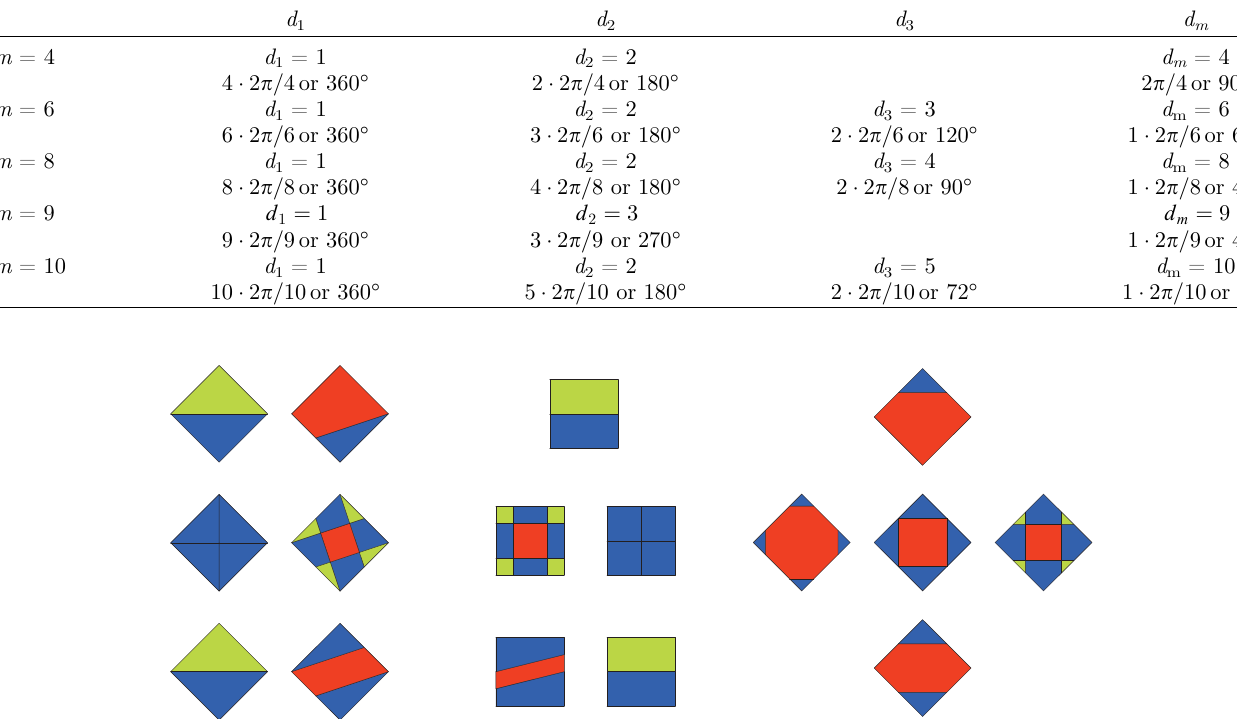
Figure 12. Ways of cutting for a square for all divisors d 1 (upper row), d 2 = 2 (lower row) and d m = 4 (central row).